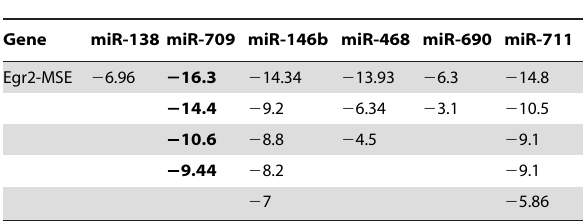
Table 2. STarMir analysis of accessibility of miRNA binding sites in targets ( SD G total,